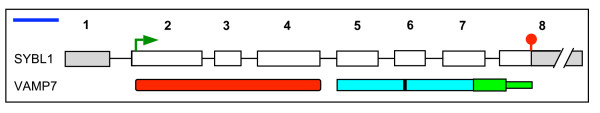
Genomic structure of SYBL1 and domain architecture of VAMP7. Top: exon-intron structure of the human gene SYBL1 (AJ004799). The 100 bp reference bar (blue, top left) only refers to exons; introns are not to scale. Exons are numbered: coding regions are white and non-coding ones are grey; start (green arrow) and stop (red circle) codons are indicated. Bottom: domain architecture of the encoded protein VAMP7 (P51809): Longin domain (red), SNARE motif (cyan; the black vertical bar indicates the conserved arginine of the polar layer) and transmembrane region (light green) with intravesicular tail (thin light green line).